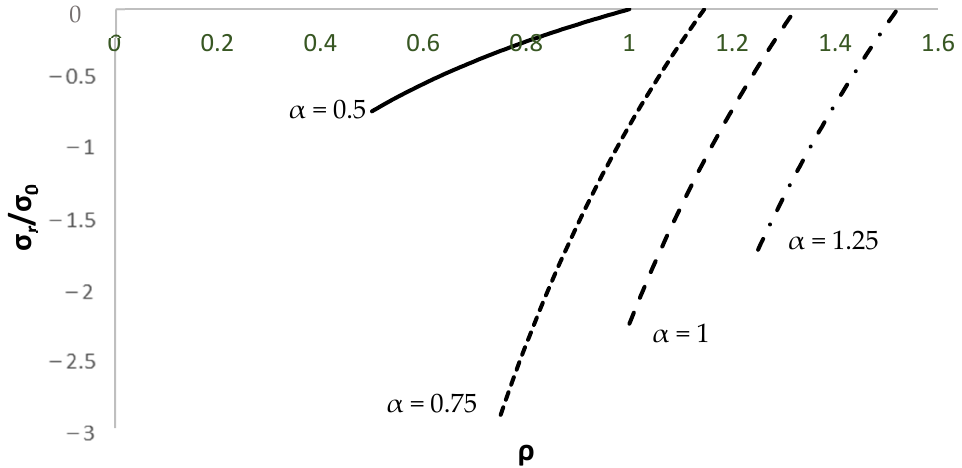
Figure 5. Radial distribution of the radial stress at ν = 10 and several values of α .